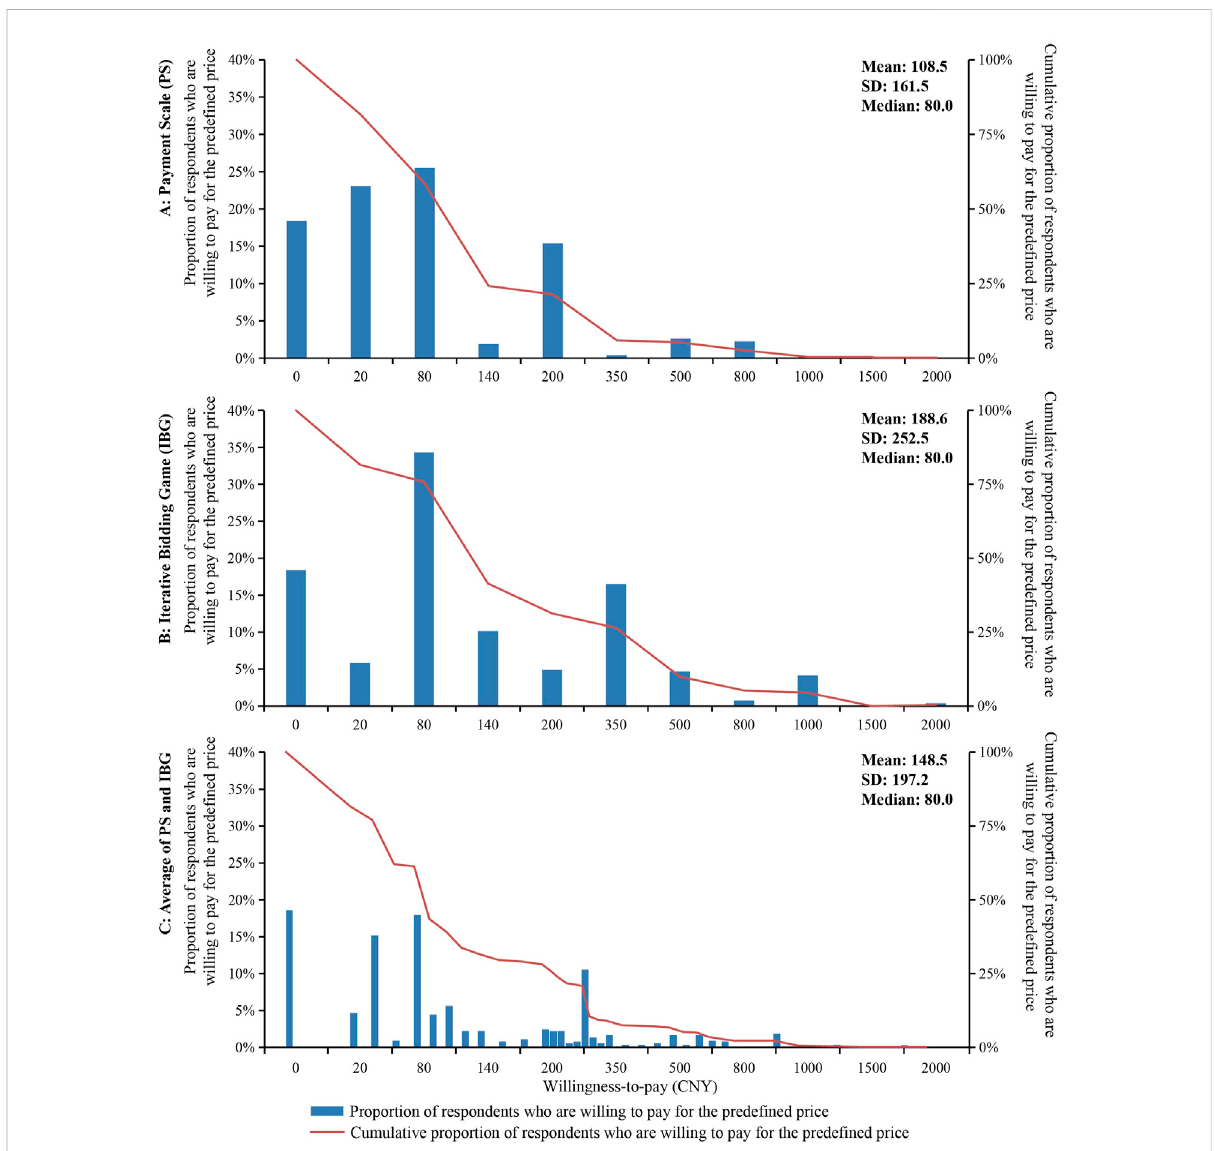
FIGURE 2 Willingness to pay distributions and demand curves of COVID-19 vaccine booster